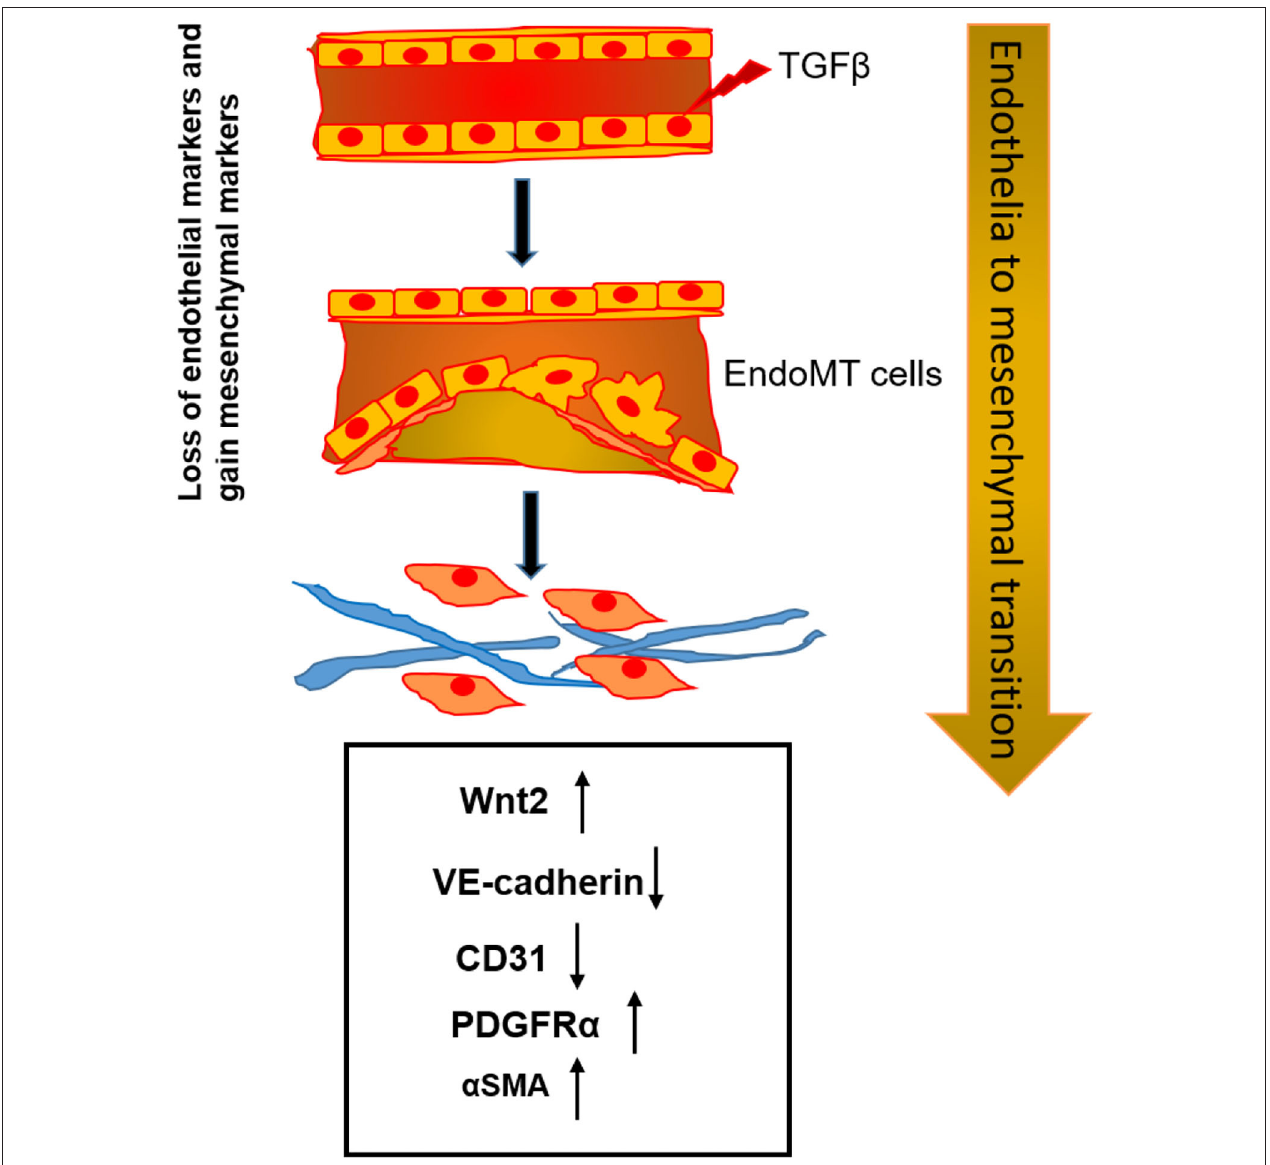
FIGURE 6 | TGF- β induces EndMT in atherosclerosis. The TGF- β signaling activation initiates EndMT and induces changes in the level of the endothelial markers, VE-cadherin, CD31, and the mesenchymal makers, PDGFR α and α SMA. Suppression of endothelial TGF- β receptor expression arrest EndMT